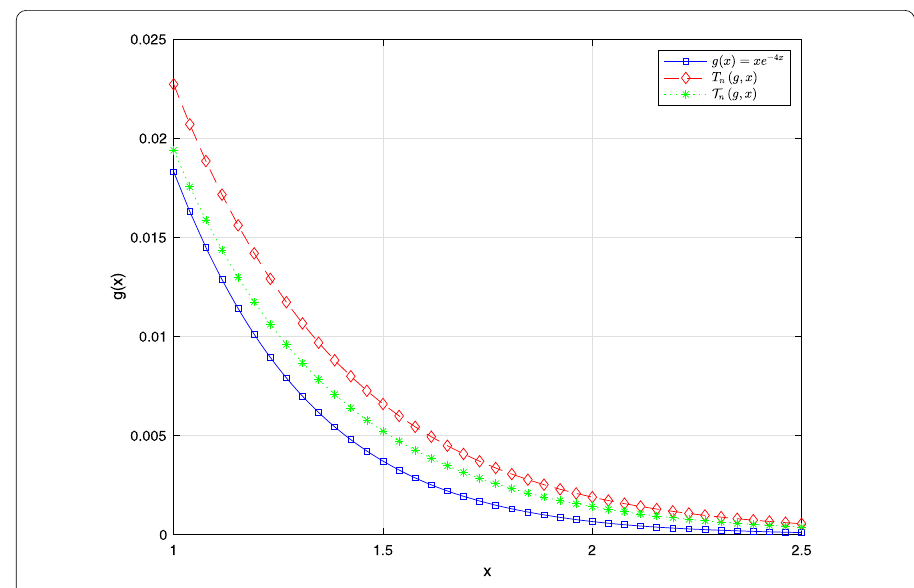
Figure 1 T n ( g , x ) and T n ( g , x ) approximation of test function g ( x ) = xe –4 x on an equally spaced evaluation grid of [1,2.5] with n =